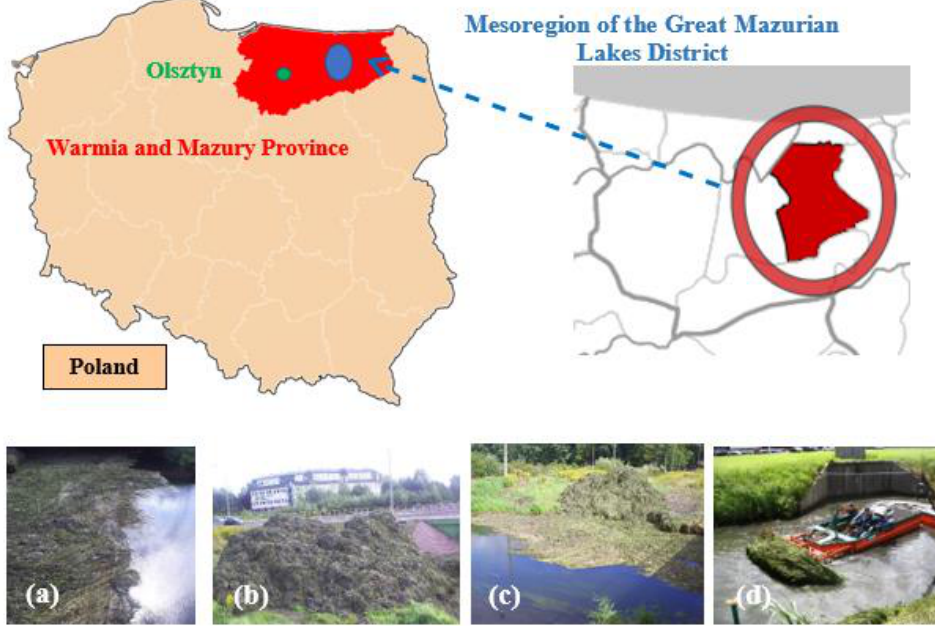
Figure 1. Location of the hydrophyte harvest area and the appearance of fresh biomass. ( a ) Harvesting of the aquatic plant biomass by bottom hacking; ( b ) harvested and periodically stored aquatic plant biomass, Łyna River, Olsztyn, Poland; ( c ) harvested and periodically stored aquatic plant biomass, shipping channel, Mazurian Lake District; ( d ) aquatic biomass harvested by mowing shipping channel, Mazurian Lake District.